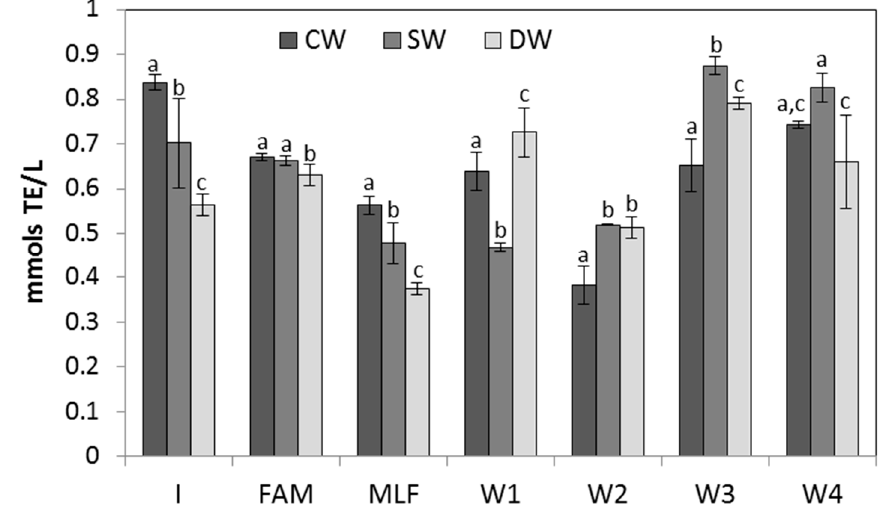
Figure 2. Values of antioxidant activity measured with the FRAP method during the winemaking process in CW, SW, and DW. Different letters in the same stages of winemaking indicate significant differences between CW, SW, and DW by ANOVA test ( p < 0.05).